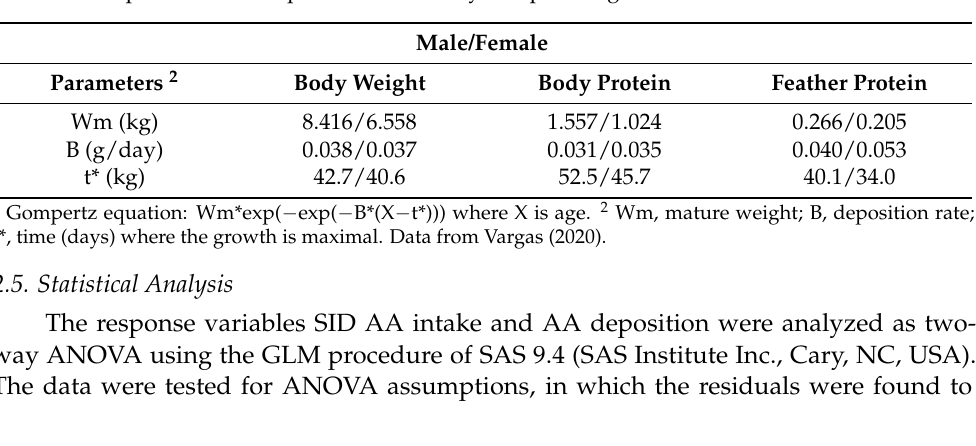
Table 4. Gompertz 1 function parameters of body and protein growth of broiler